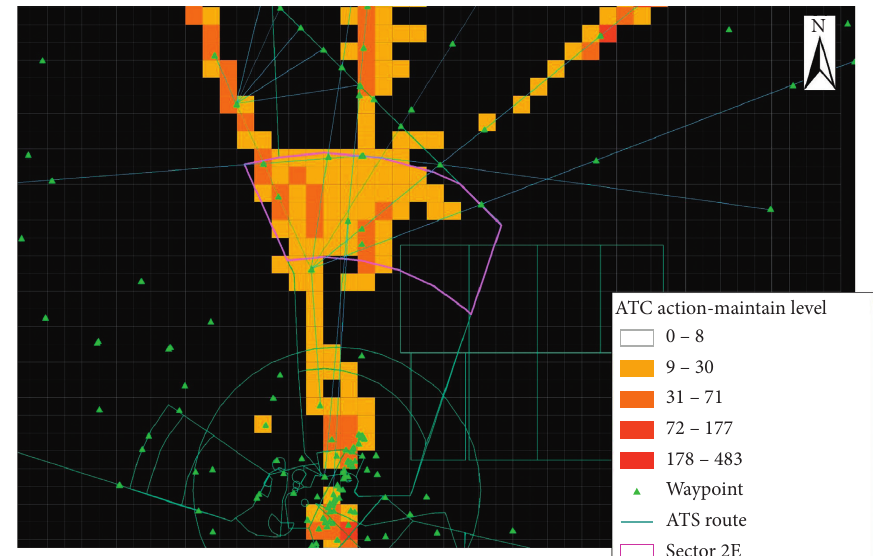
Figure 6: Distribution of ATCO